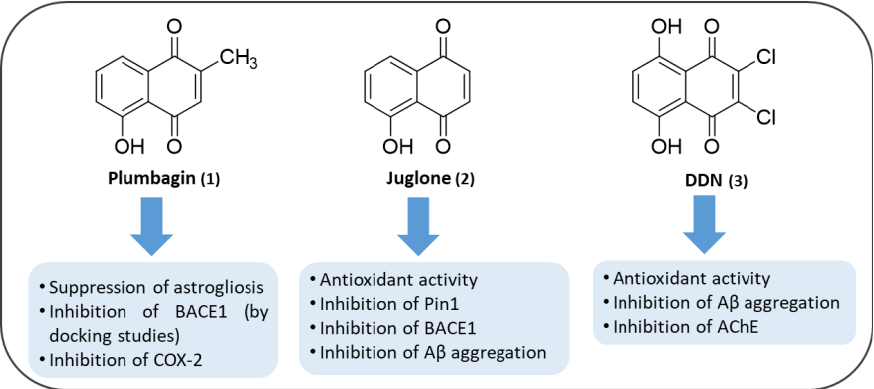
Figure 4. Chemical structures and biological properties of plumbagin, juglone and DDN against